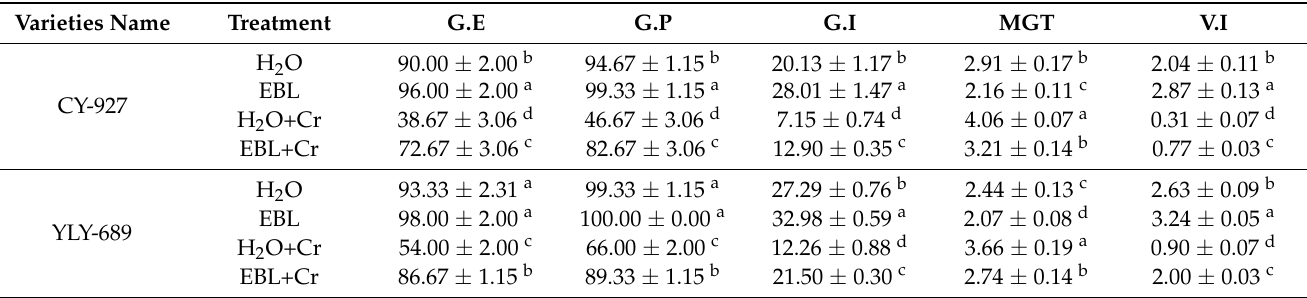
Table 1. Effect of Cr toxicity on the seed germination parameter in seeds primed with EBL compared to seeds primed with water in two different rice cultivars.